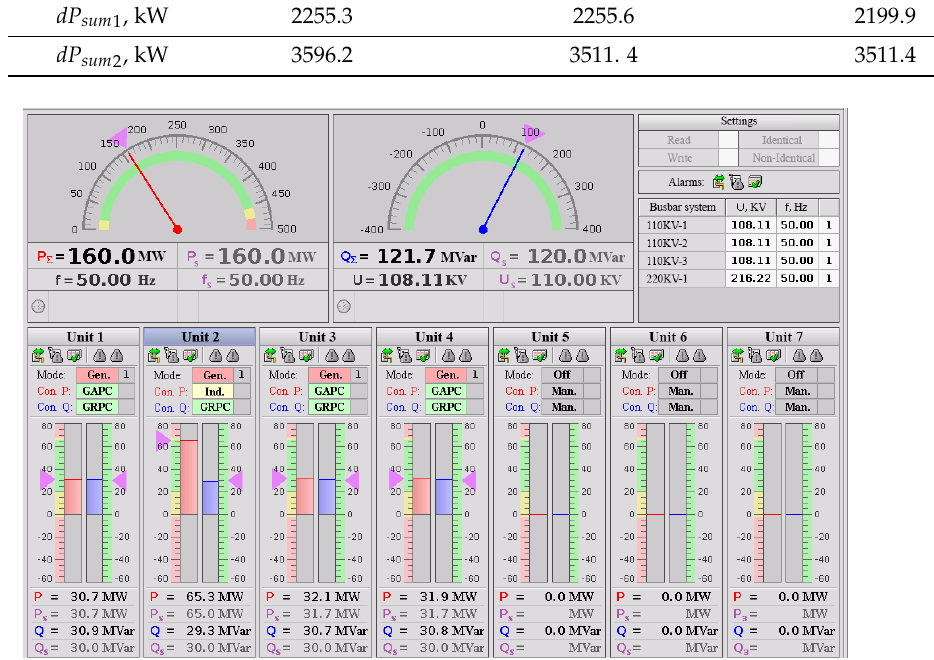
Figure 7. The main window of the digital AGC system: unit 2 individual control is active.